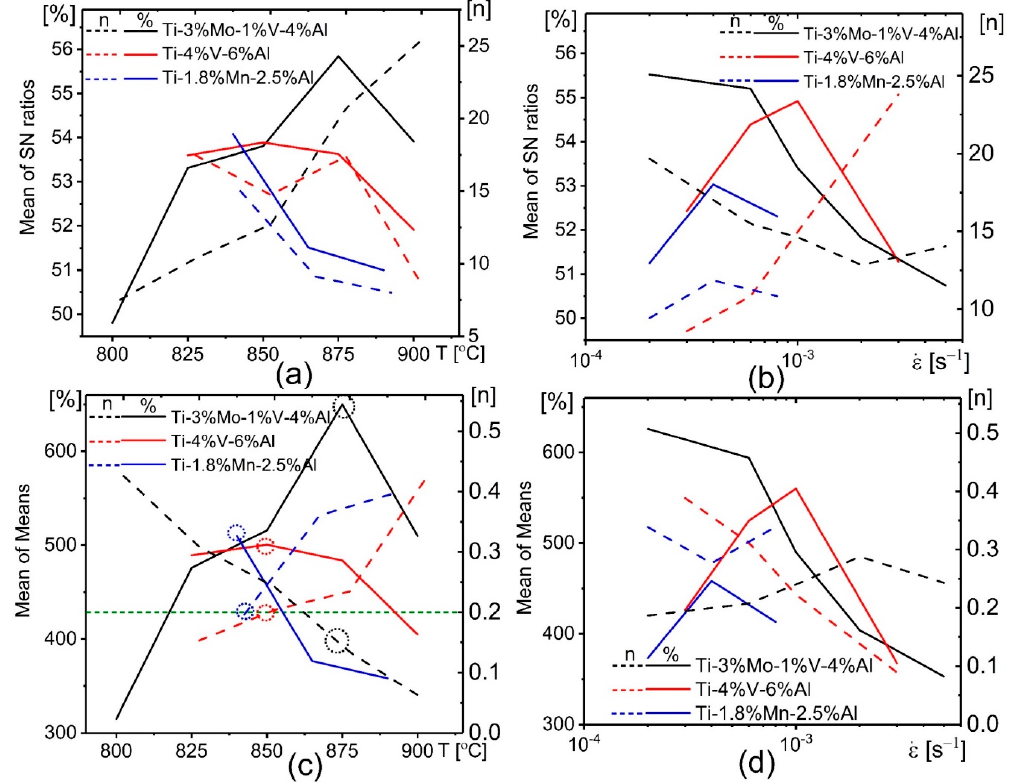
Figure 9. Elongation to failure vs temperature and strain rate dependence for the studied alloys: means of the S/N ratios ( a , b ); and the mean of means ( c , d ). The percentage of the contribution and the rank after the analysis of variance (ANOVA) for the S/N ratio and the means of elongation to failure, for the investigated alloys, are shown in Table 6. Table 6. Analysis of variance for the S/N ratios and mean of the elongation to failure.